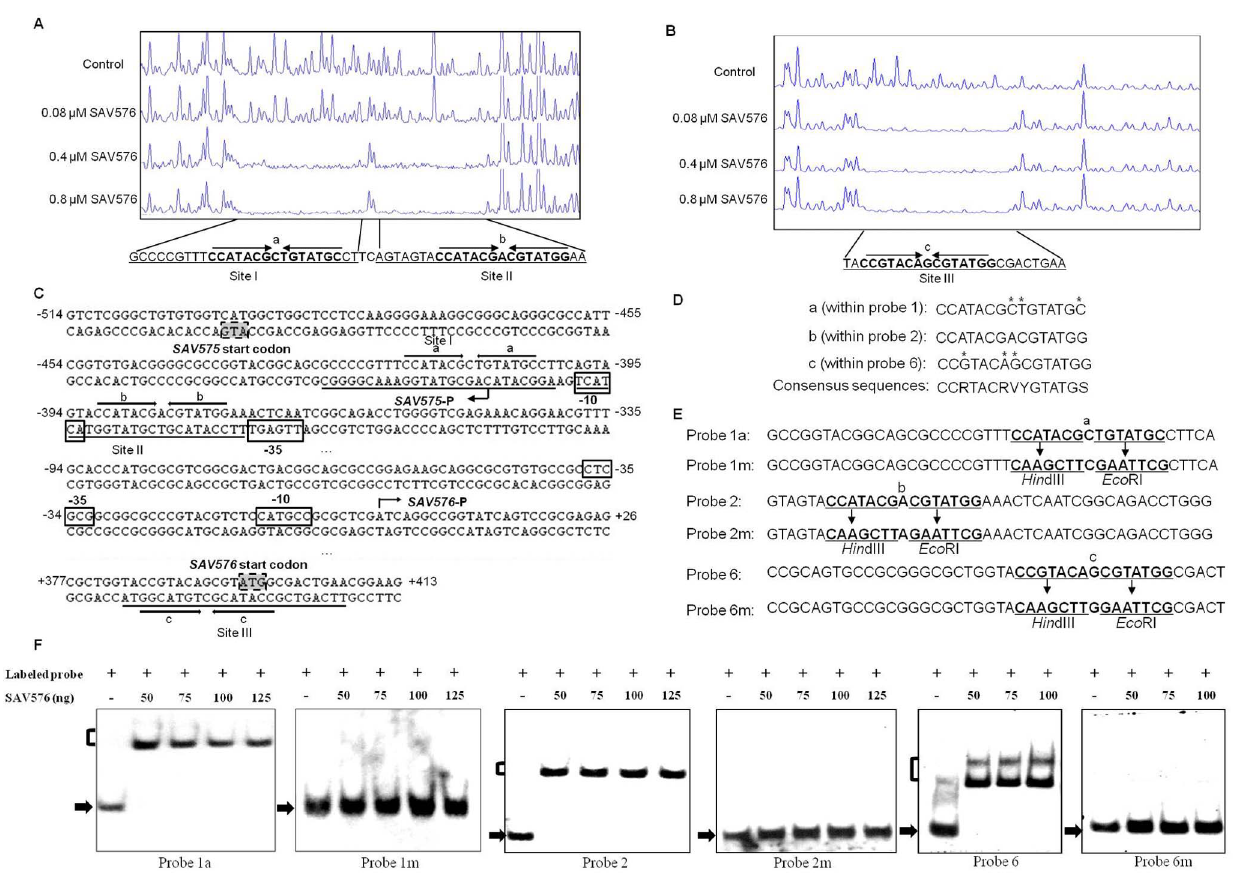
Figure 5. Determination of the binding sites of the SAV576 protein. ( A and B ) DNase I footprinting assay of SAV576 on the SAV575 ( A ) and SAV576 ( B ) promoter regions, respectively. The fluorograms correspond to the control DNA (10 m M BSA) and to the protection reactions with increasing concentrations of His 6 -SAV576 protein, respectively. ( C ) Nucleotide sequence of the SAV575 - SAV576 promoter region and SAV576-binding sites. The numbers indicate the distance (nt) from the transcriptional start point of SAV576 . Solid lines, SAV576-binding sites; arrows, inverted repeats; bent arrows, transcriptional start points and transcription orientation; boxed areas, putative 2 10 and 2 35 regions; shaded areas, translational start codon. ( D ) Three 15-bp palindromic sequences ‘‘a’’, ‘‘b’’, and ‘‘c’’. The mismatched nucleotides in comparison with sequence b are indicated by asterisks. ( E ) Mutations introduced into the 15-bp palindromic sequences. Each of the probes used was 43-bp. Probes 1a, 2, and 6 contained sequences a, b, and c, respectively. Hin dIII and Eco RI sites were generated at sequences a, b, and c to produce mutated probes 1m, 2m, and 6m, respectively. The nucleotides changed are indicated by underlining. ( F ) EMSAs using the mutated DNA probes. The free probes are indicated by solid arrows, and the retarded DNA fragments are indicated by